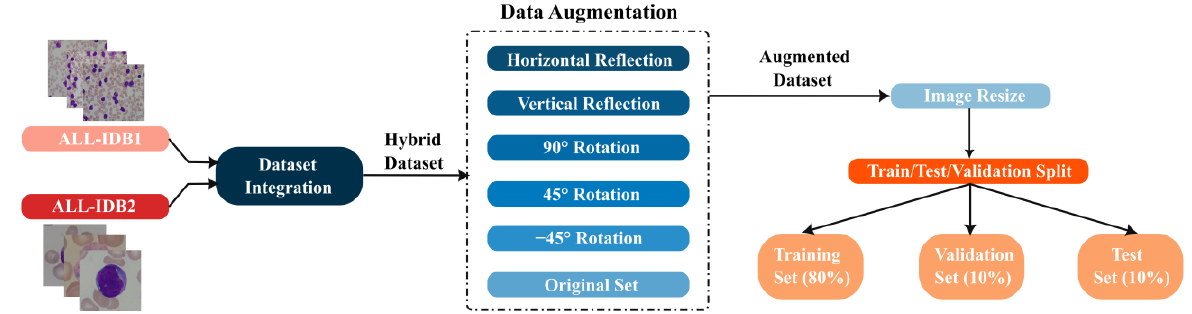
Figure 2. Preprocessing procedures applied to the input ALL-IDB datasets.